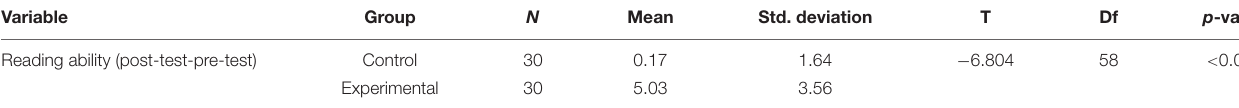
TABLE 10 | Frequency distribution of teachers’ answers to the questionnaire. Very low Low Moderate High Very high Mean Std. deviation p